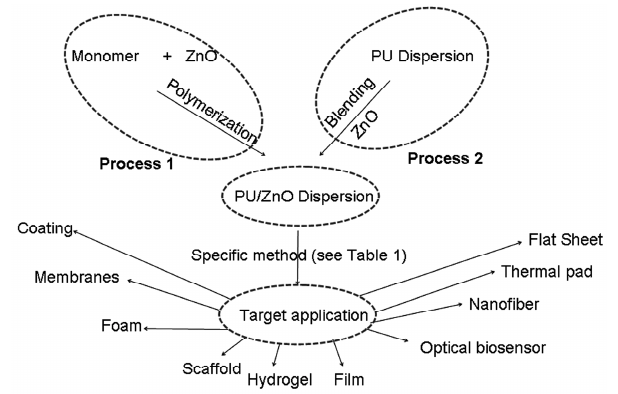
Figure 2. Preparation of PU/ZnO composite and their application.